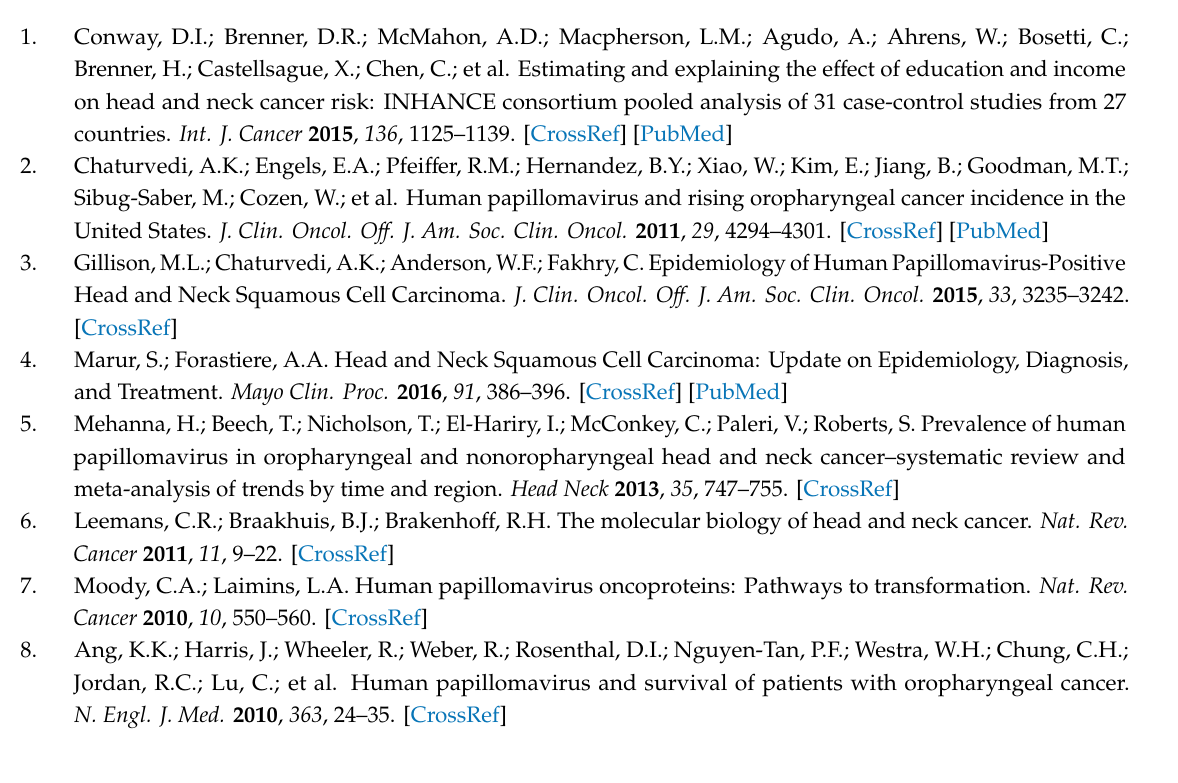
Figure S4: Recurrence free survival in dependence of the SLC3A2 expression status and correlation with clinicopathological characteristics, Figure S5: Patient survival in dependence of the lamin B1 expression status, Table S1: Complete list of proteins identified in the mass spectrometric analysis, including label-free quantification (LFQ) values, numbers of unique peptides (UP), Boruta score, t test, and observations from Sepiashvili et al. for each protein, Table S2: Clinicopathological characteristics of tissue microarray OPSCC